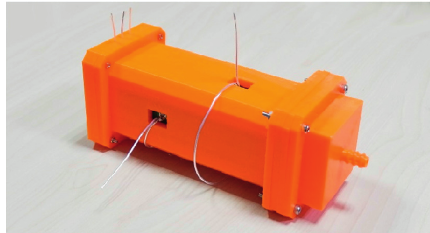
Figure 11: Mass analysis device used for high-pressure mass spectrometry.